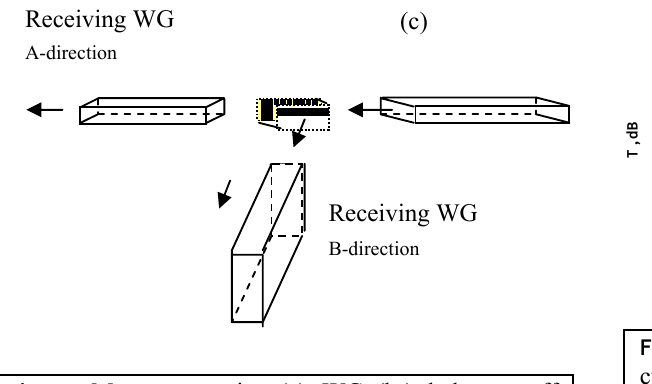
Fig. 2. Metastructure in (a) WG, (b ) below-cutoff rectangular section and (c) free